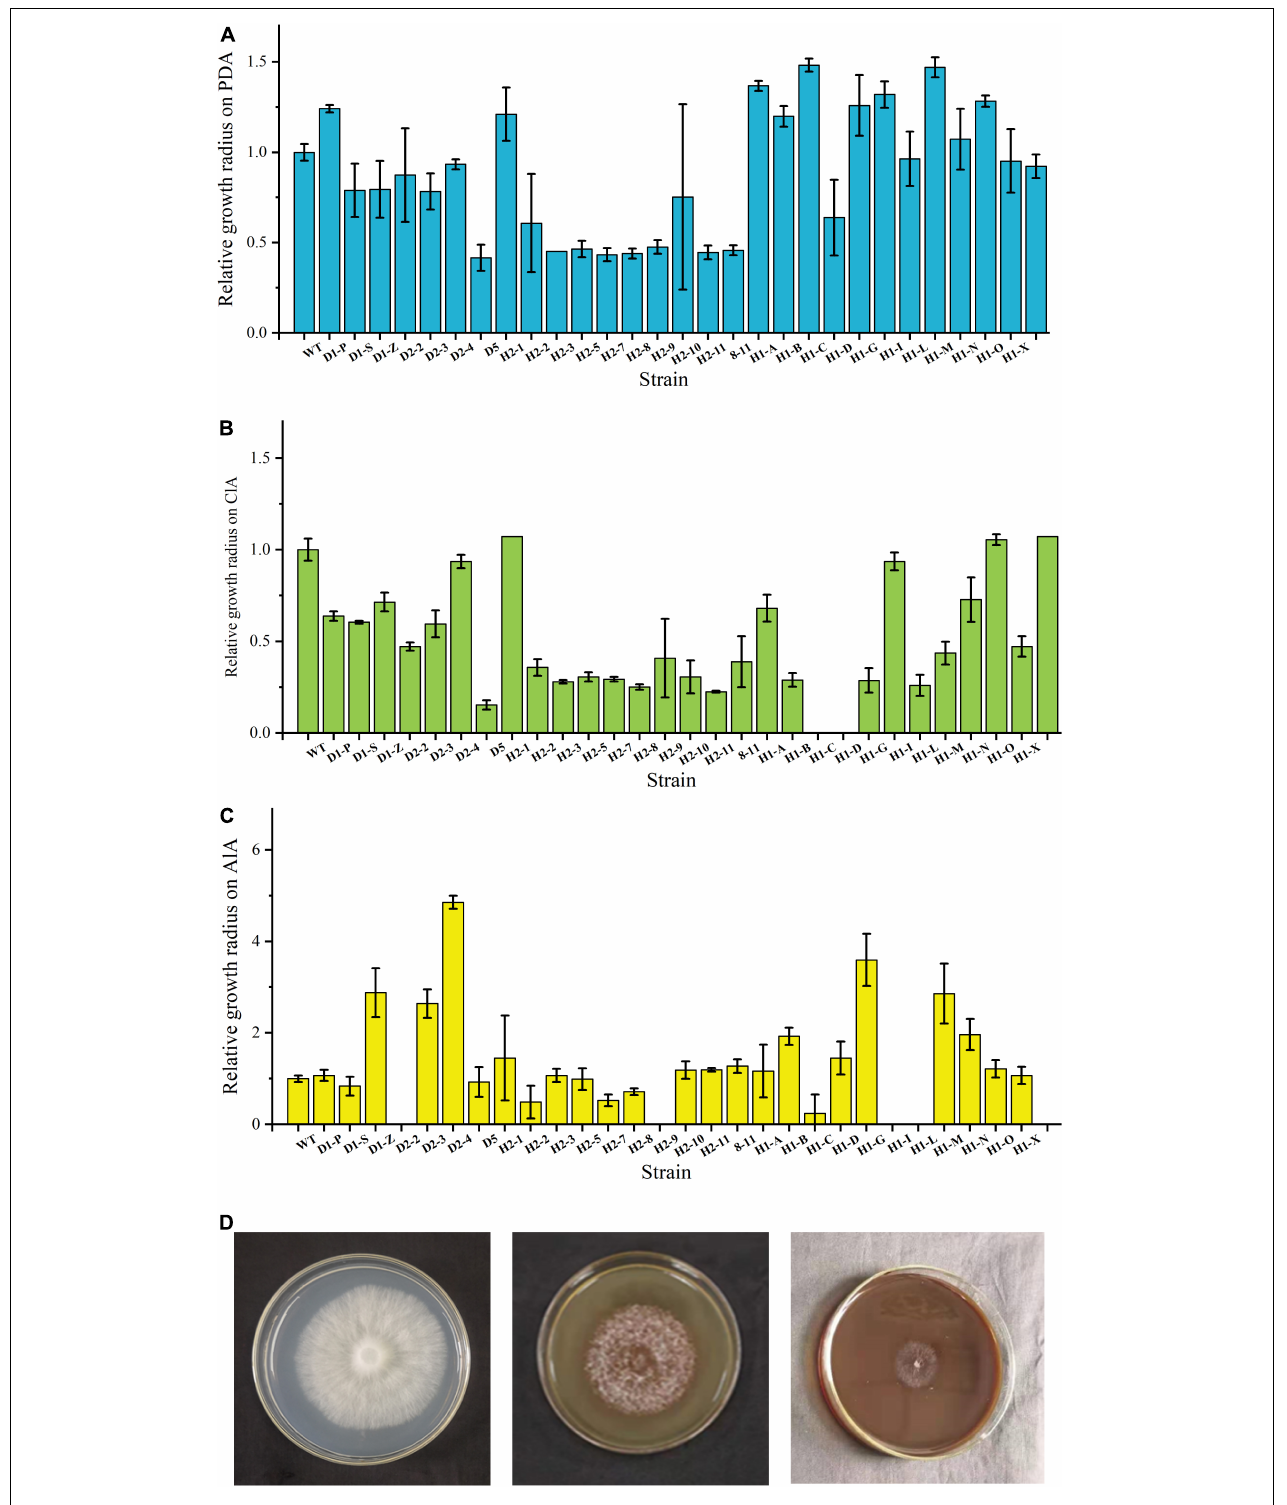
FIGURE 1 | Growth status of WT and fusants on different plates. (A) Fusant/wild-type growth radius ratio histogram on PDA plates after incubation. (B) Fusant/wild-type growth radius ratio histogram on CLSS. (C) Fusant/wild-type growth radius ratio histogram on ALS. (D) Growth status of WT on PDA (left), CLSS (middle) and ALS